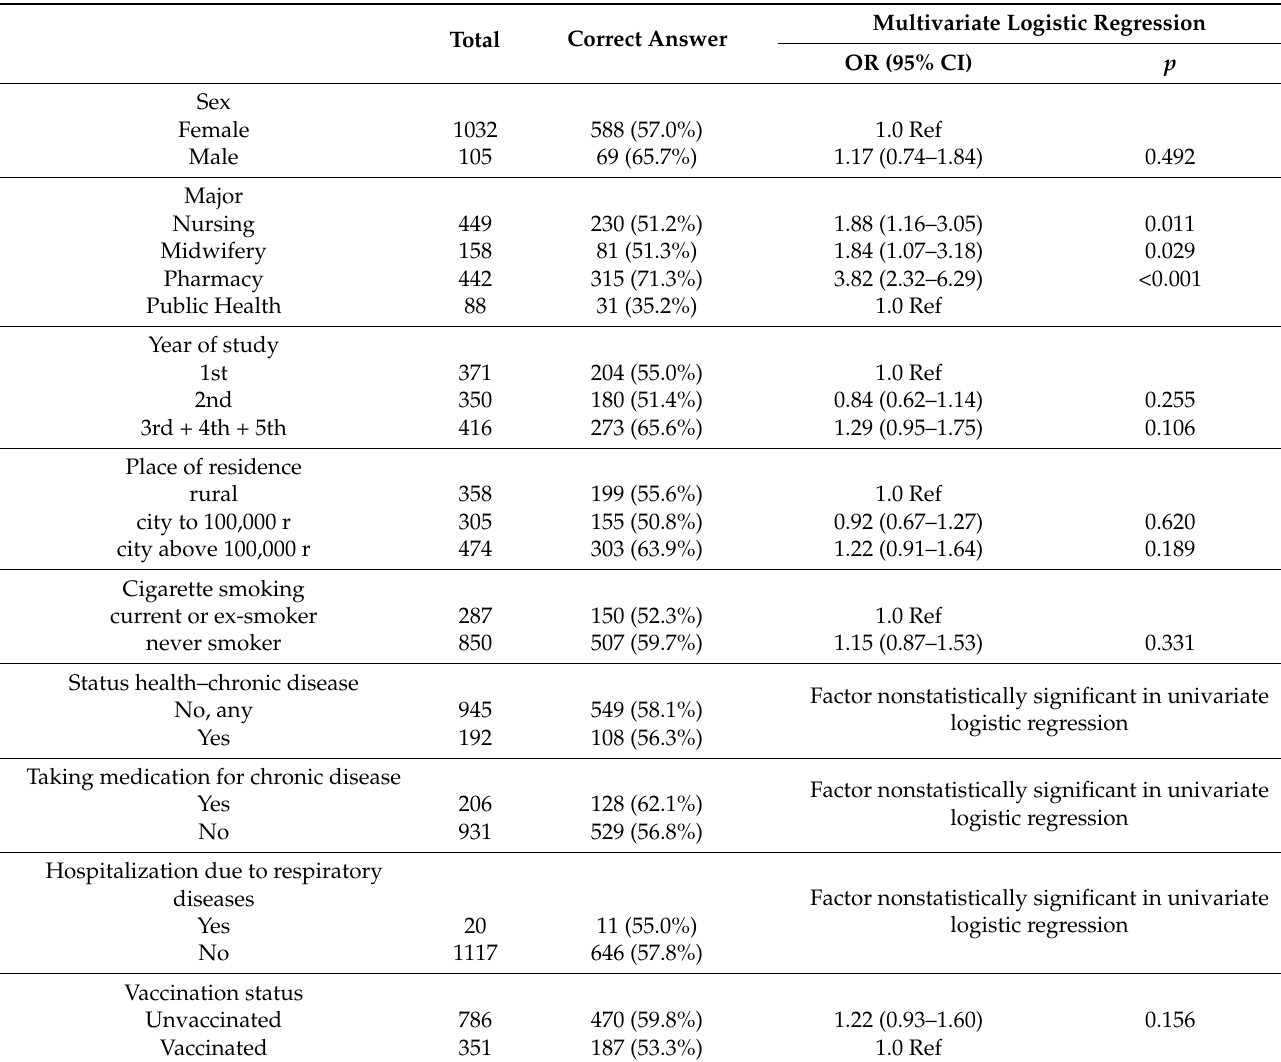
Table 6. Associations between the demographic factors (sex, major, year of study, place of residence, smoking cigarettes, status health, taking medication, and vaccination status) and the students’ knowledge about the effectiveness of the flu vaccine in protecting against other upper respiratory tract